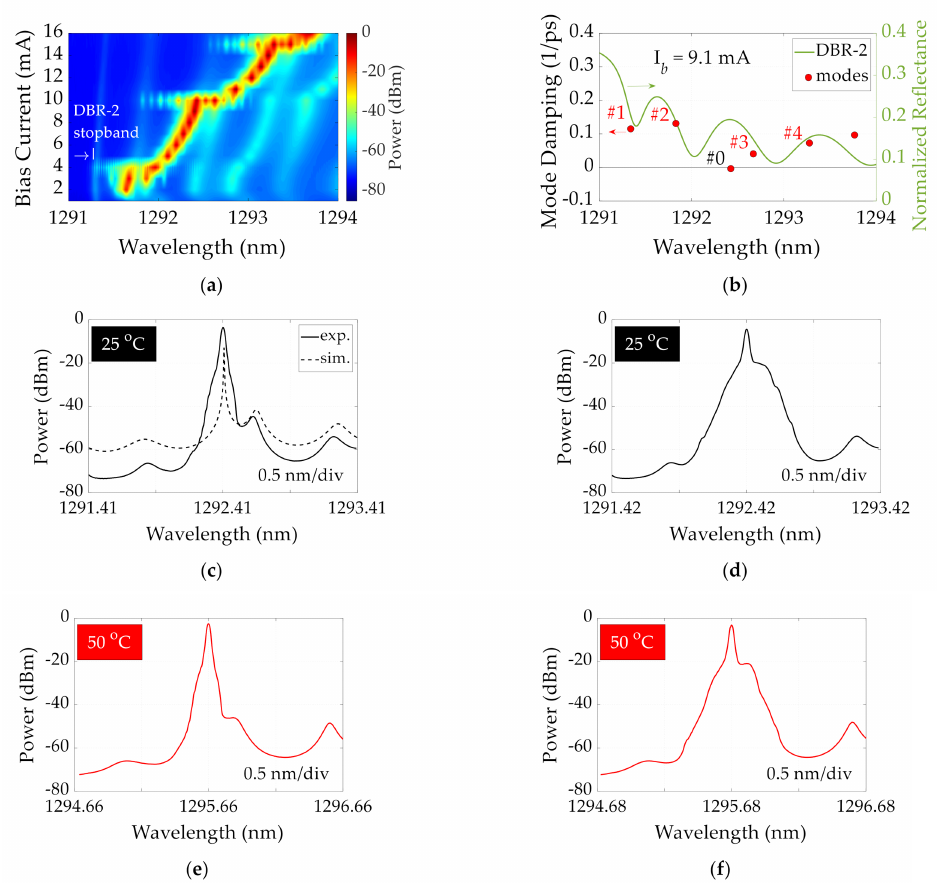
Figure 3. Spectral characteristics: ( a ) Contour plot of the experimentally-obtained optical spectra Figure 25 ◦ C; ( b ) Longitudinal mode analysis at a bias current of 9.1 mA (25 ◦ C operation is assumed). The reflectance of DBR-2 is also shown as a reference. ( c ) Experimental and simulated spectra at a bias current of 9.1 mA and 25 ◦ C; ( d ) Experimental spectra as in ( c ), but including also a 60 GBaud PAM-4 RF modulation. ( e ) Experimental spectra at a bias current of 15.1 mA and 50 ◦ C; ( f ) Same as ( e ), but including also a 60 GBaud PAM-4 RF